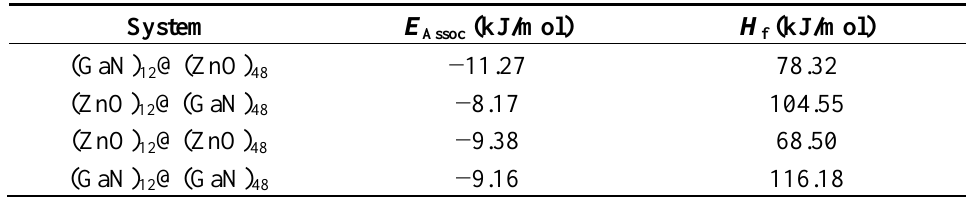
Table 3. Energy of association, E H per atom for double bubble clusters as defined in Equation f